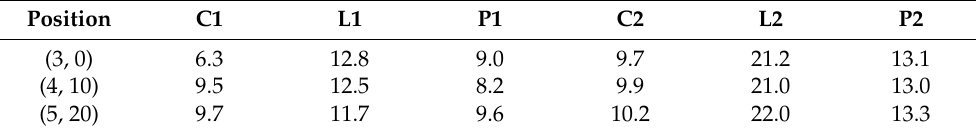
Table 4. Standard deviation of the pixels of the inclusion